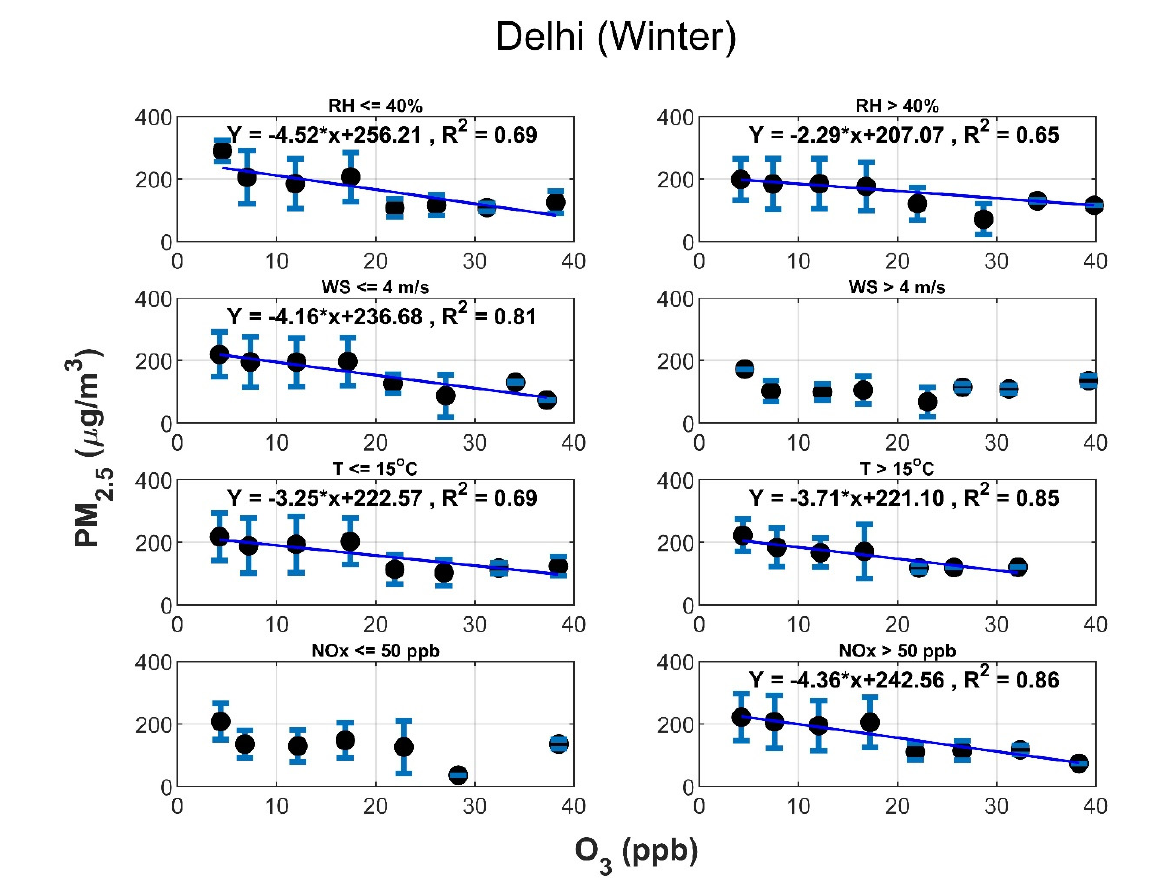
Figure 6. Dependence of PM 2.5 concentrations on O 3 in Delhi during the winter season for different meteorological parameters.